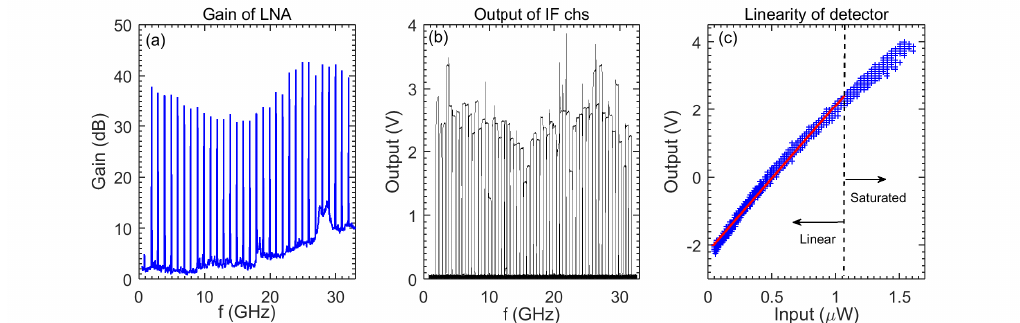
Figure 2. (a) the gain of the wide-band low noise amplifier in the IF module, (b) the frequency response of each IF channel, and (c) the power response of the detector.